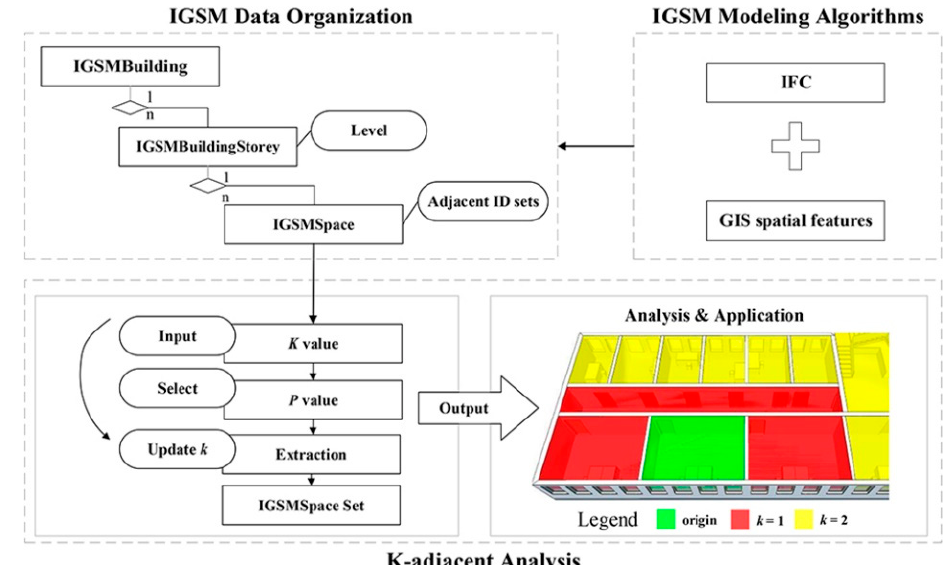
Figure 3. Workflow of the proposed method.